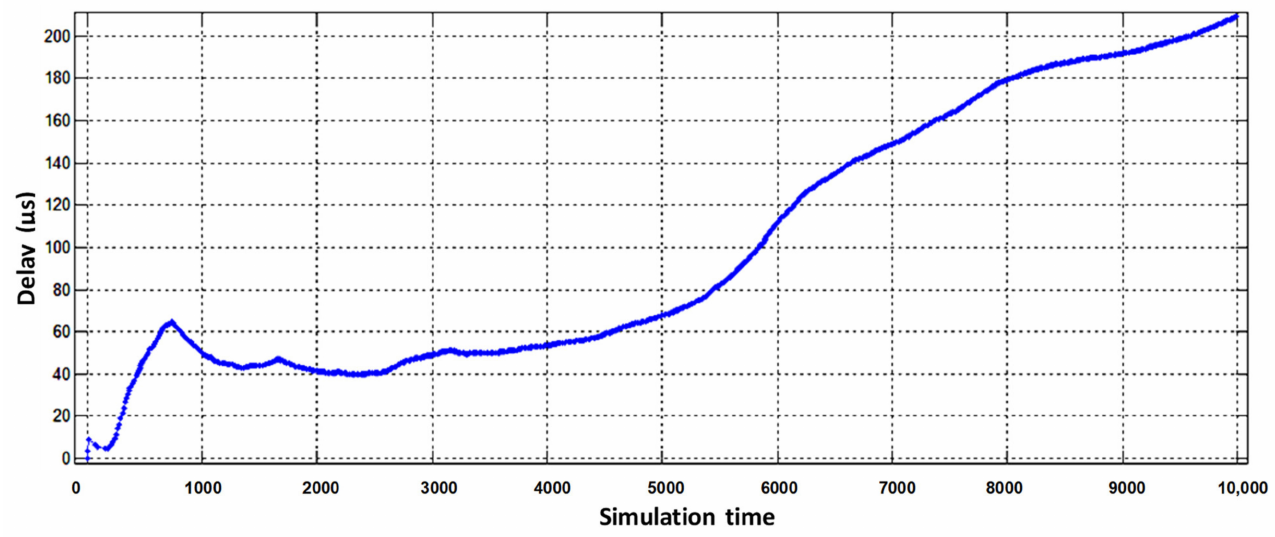
Figure 11. Delay of virtual router buffering when serving ( a ) video, ( b ) voice, ( c ) data.